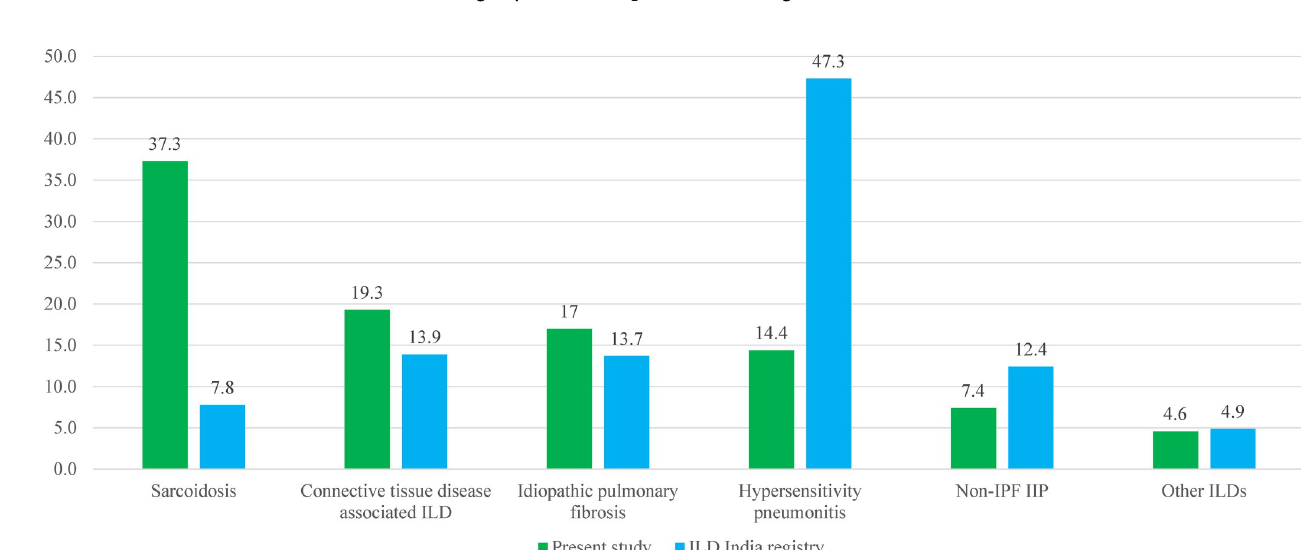
have an almost equal prevalent burden contrary to other world regions, where sarcoidosis and IPF are the most prevalent ILDs [4, 13, 36]. The ILD spectrum in India remains contentious. In our previous study, sarcoidosis (42.2%) was the commonest ILD (n = 803), followed by IPF (21.2%), CTD-ILD (12.7%), and HP (10.7%). The present analysis, which includes the patient population of our previous study, reveals a slightly different spectrum. Though sarcoidosis (37.3%) remains the commonest, the